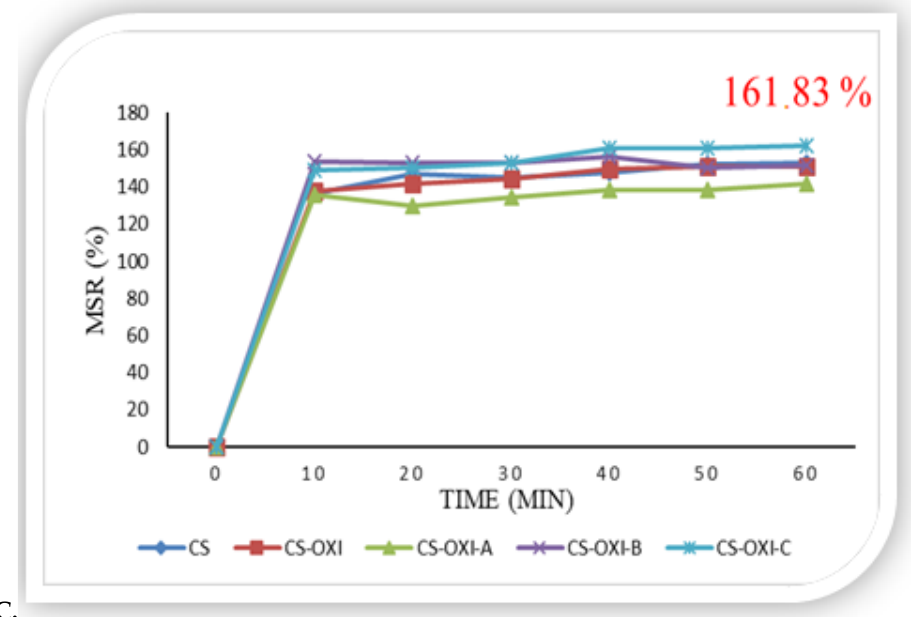
Figure 5. Membrane Swelling Ratio of polymer films at 5 ( A ), 7 ( B ) and 10 pH ( C ).